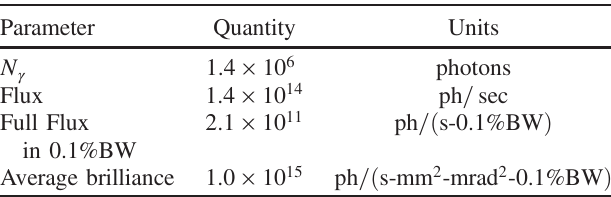
TABLE V. X-ray source